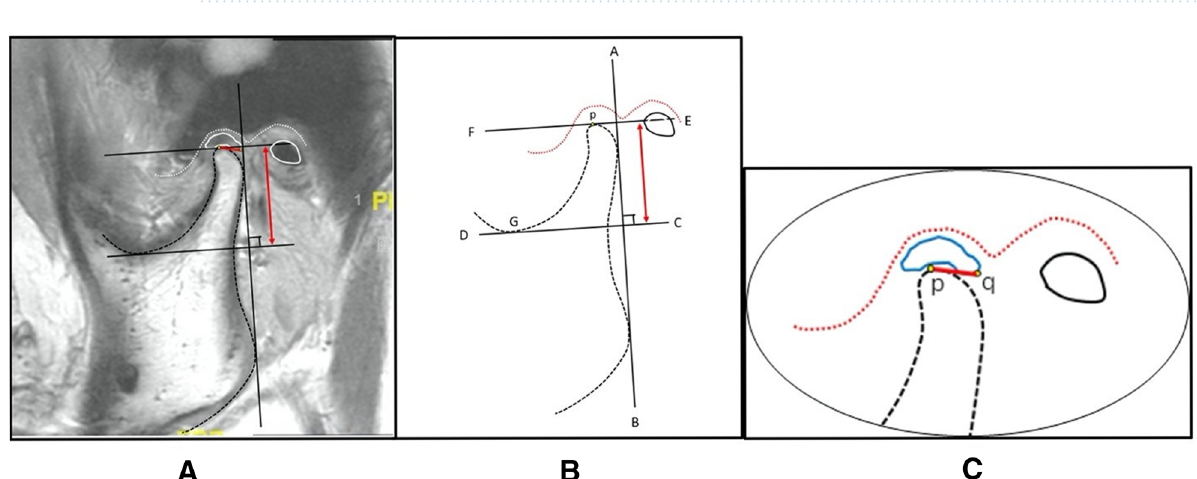
Figure 3. An illustrated diagram demonstrating the key reference points on MRI measurements after surgery. ( A ): A postoperative MRI sagittal view; ( B ): A schematic diagram showing reference points and lines for condylar height measurement; ( C ): A schematic diagram demonstrating reference points and lines for measurement of disc reposition